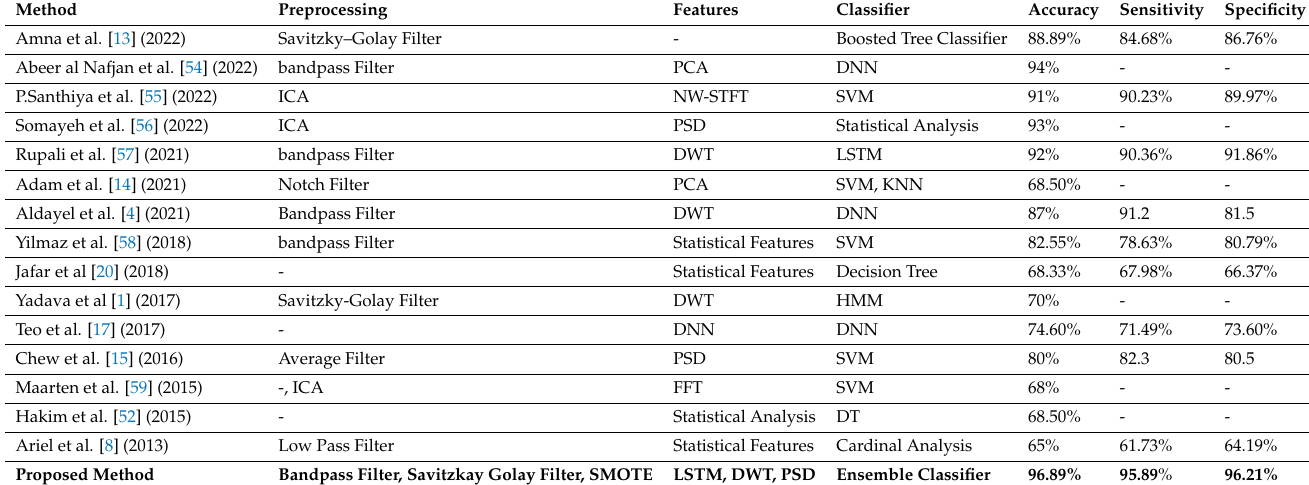
Table 7. Comparison of different state of the art customer choice recognition